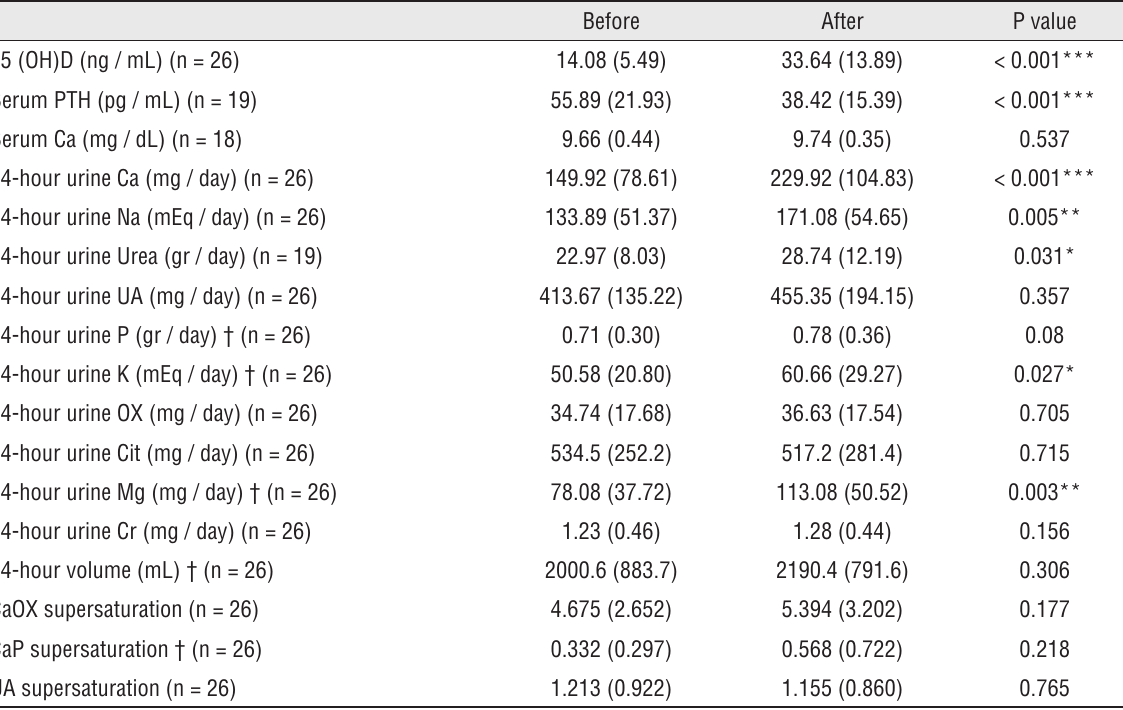
Table 2 - Urine and serum parameters before and after vitamin D supplement therapy. All values are mean (SD) and p-value stands for the paired t-test unless otherwise